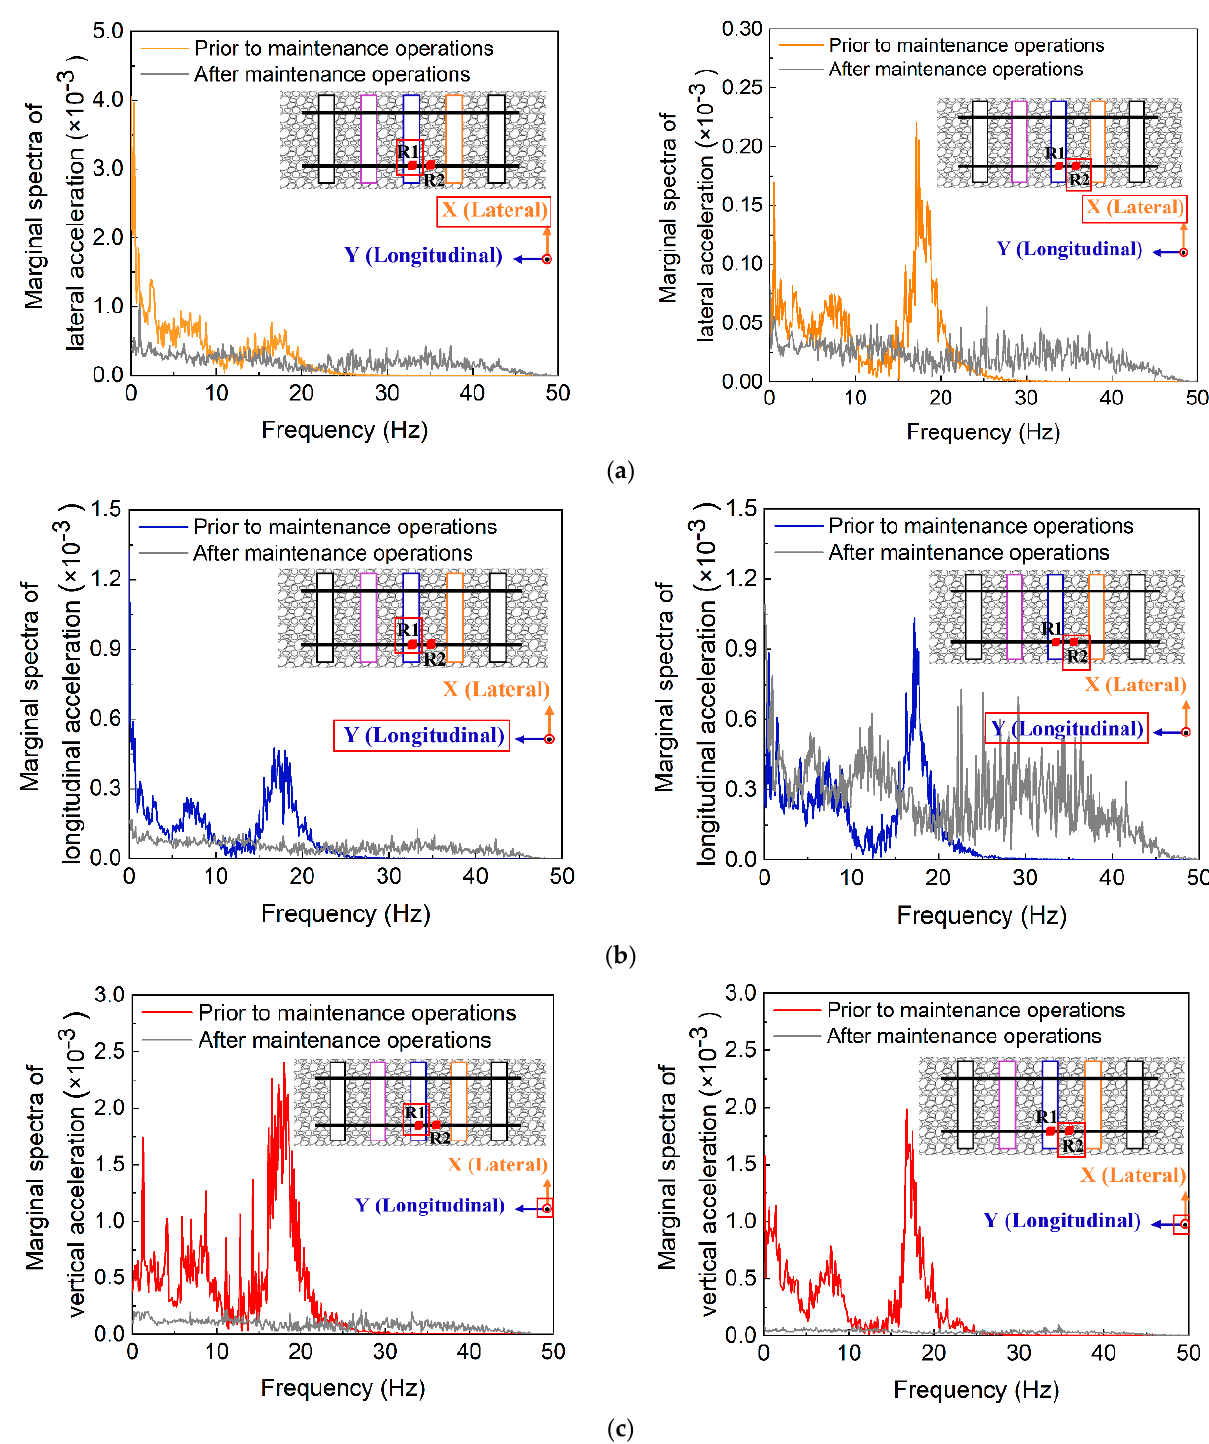
Figure 19. Comparison of marginal spectra of ( a ) lateral, ( b ) longitudinal, and ( c ) vertical accelera- tion responses prior to and after maintenance operations.